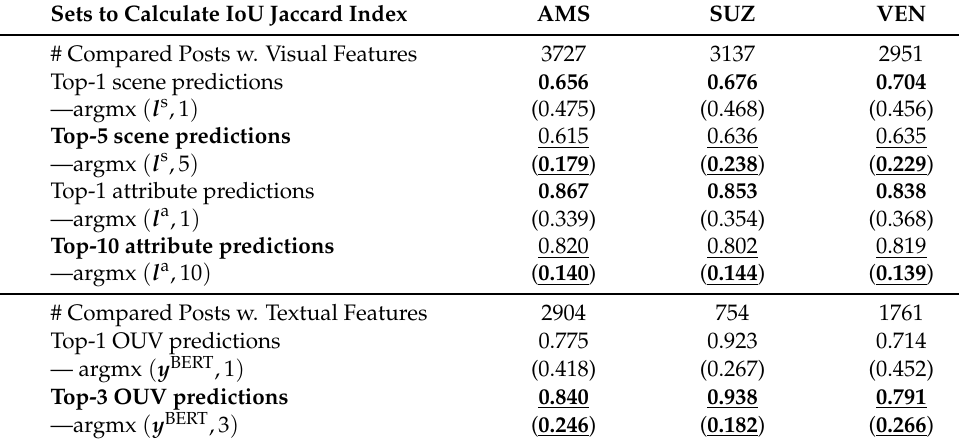
Table 3. The consistency (the mean and standard deviation of top- n IoU Jaccard Index on pre- dicted sets) of generated features. For visual features, predictions with different input image sizes (150 × 150 px and 320 × 240 px) are compared; for textual features, average sentence-level predictions and paragraph-/post-level predictions are compared. The best scores for each feature are in bold, and the selected ones for future tasks are underlined. “#” means “the number of” in the table. Sets to Calculate IoU Jaccard